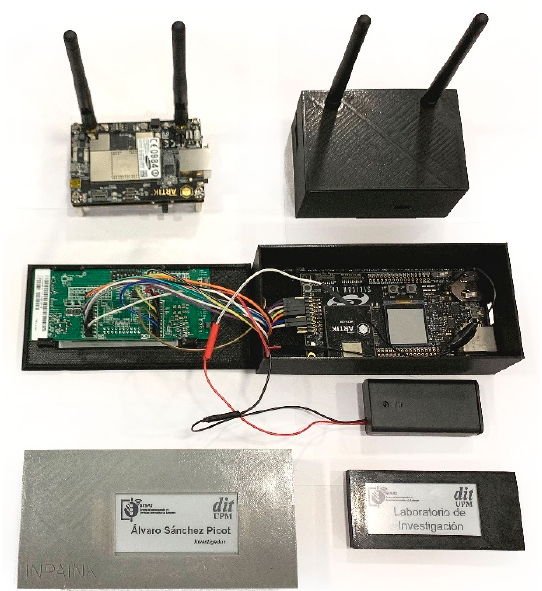
Figure 7. First real implementation of information endpoints for Smart Homes using the proposed configuration algorithm.